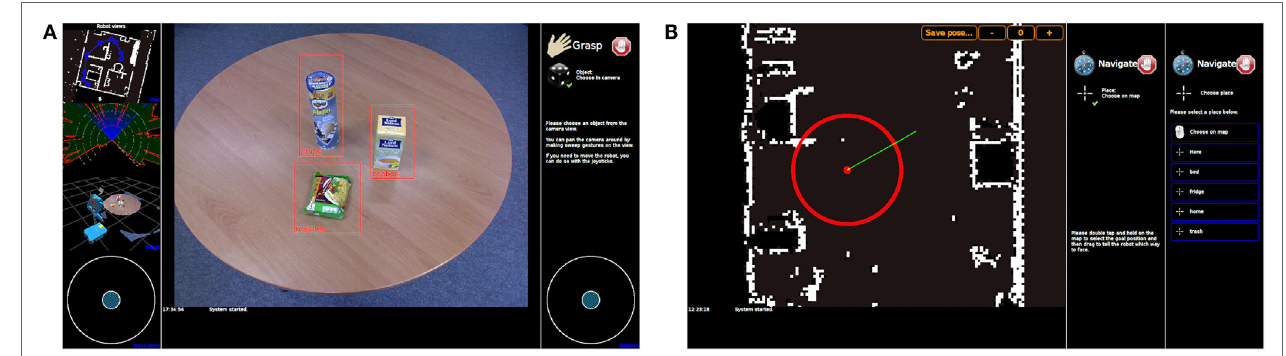
FIgURe 13 | handheld teleoperation interface (Schwarz et al., 2014) . (A) Complete GUI with a view selection column on the left, a main view in the center, a configuration column on the right, and a log message window on the bottom center. Two joystick control UIs on the lower corners for controlling robot motion with the thumbs. (B) Skill-level teleoperation user interface for navigation in a map (placed in center and right UI panel). The user may either select from a set of named goal locations or choose to specify a goal pose on a map. The user specifies navigation goal poses by touching onto the goal position and dragging toward the desired robot